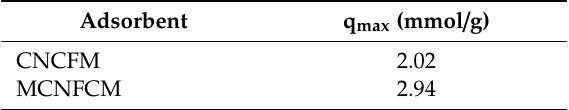
Figure 15. Breakthrough curves adsorption of CNFCM and modified CNFCM in constant 40% CO 2 , = 30 ◦ C, P = 1 Bar. T = 30 °C, P = 1 Bar. T Table 12. CO 2 adsorption of CNFCM and modified